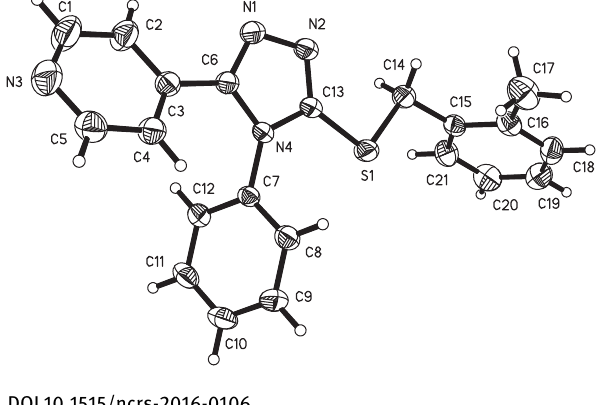
Table 2: Fractional atomic coordinates and isotropic or equivalent isotropic displacement parameters (Å 2